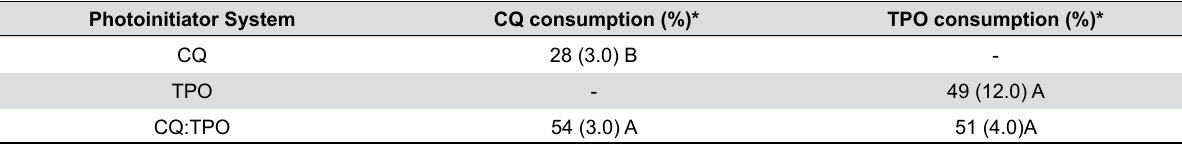
Table 3- Consumption of CQ and TPO in percentage